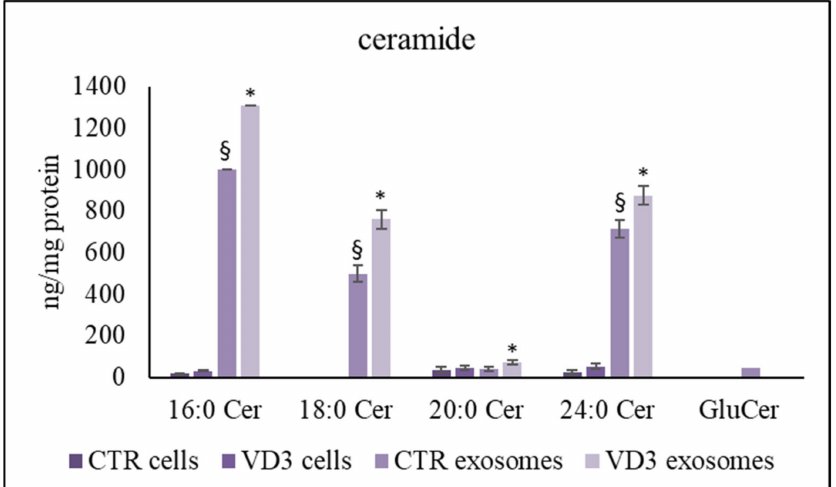
Figure 4. UFLC MS/MS analysis of ceramide species in cells and exosomes. The analysis was performed as reported in the Section 4. Data are expressed as nmol/mg protein. Data represent the mean ± SD of three independent experiments performed in duplicate (case number: 6). * p < 0.05 versus the control sample, § p < 0.05 versus cells Cer, ceramide; GluCer, glucosylceramide; CTR, control sample; VD3, vitamin D3 sample.